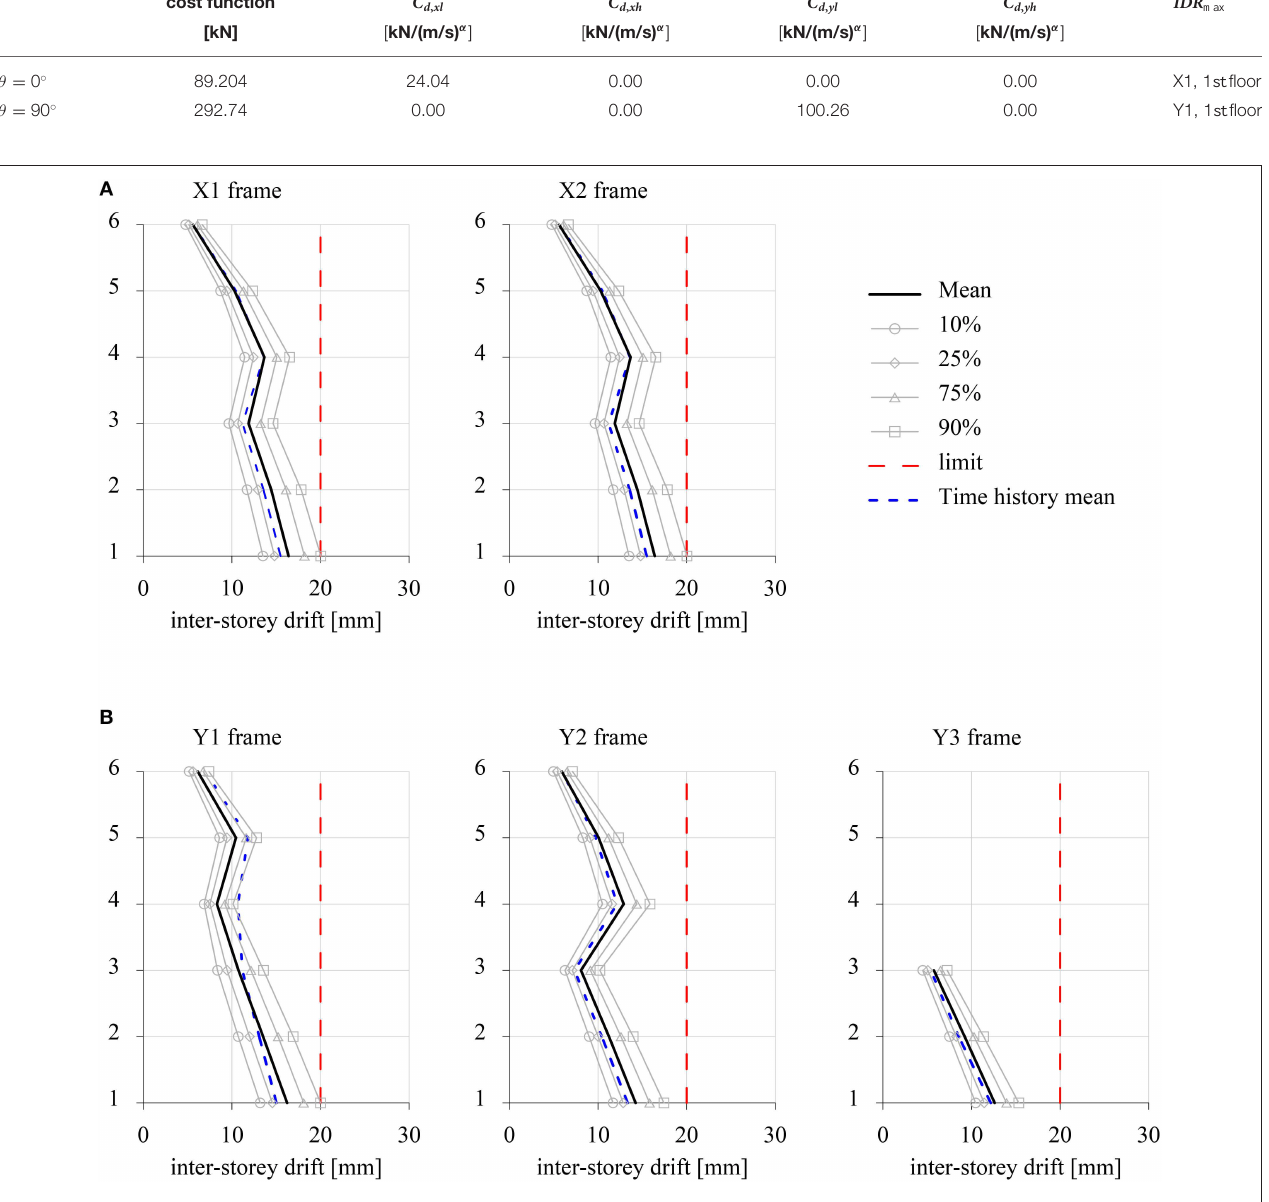
FIGURE 8 | Peak values of inter-story drifts of the Model 2 in its optimal controlled configuration. (A) θ